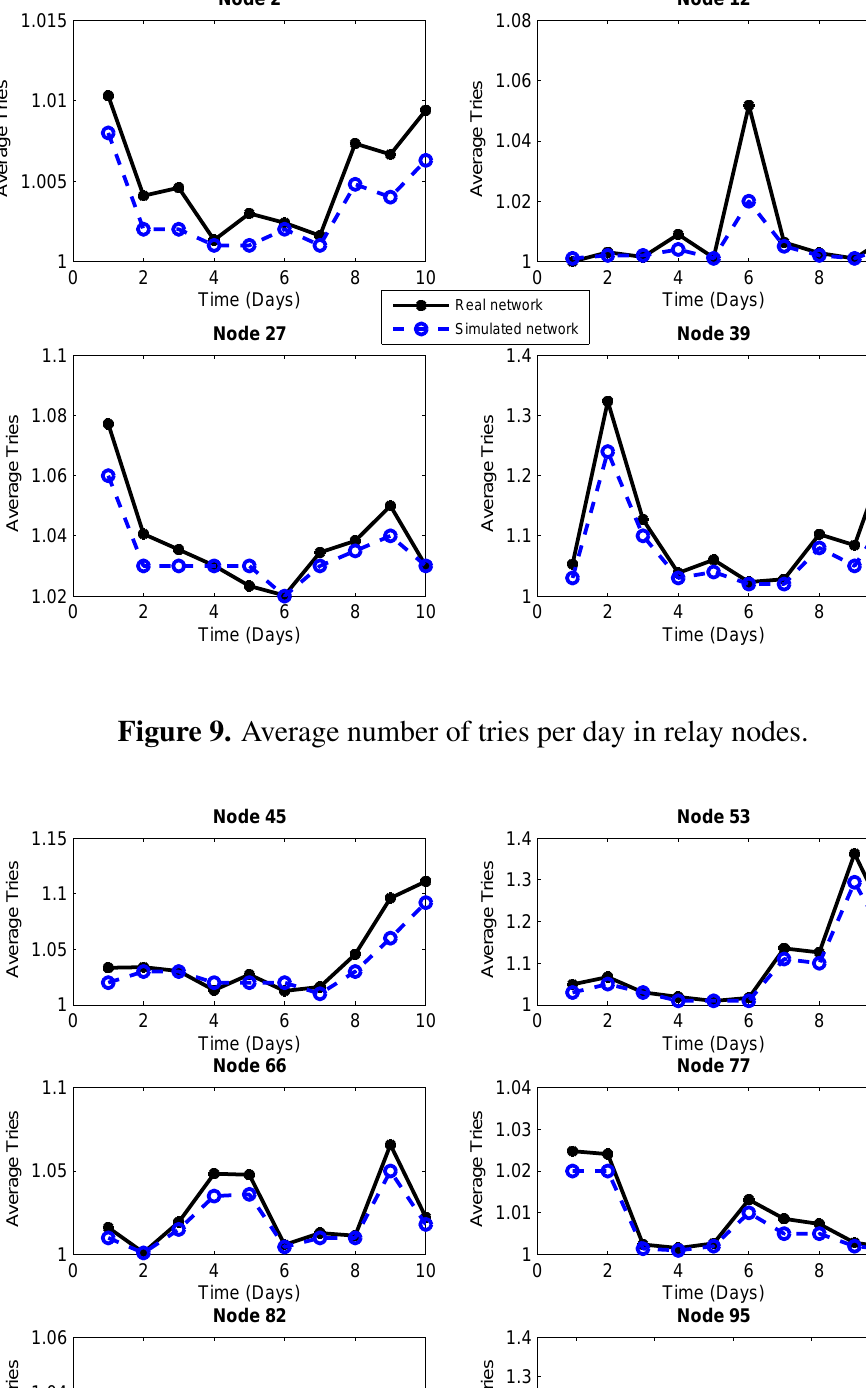
Figure 8. Average number of tries per day in source nodes.